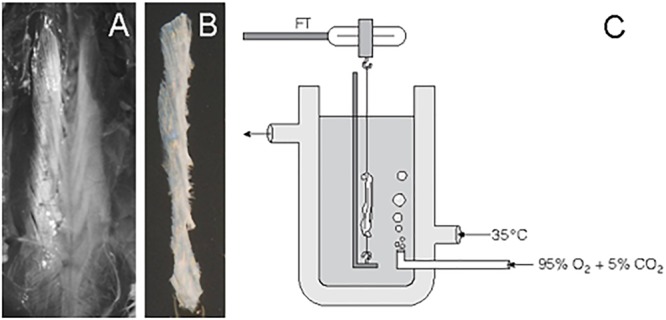
Handling of rat thoracolumbar fascia. After removal of skin and subcutaneous connective tissue, the underlying dense layer of thoracolumbar fascia was made accessible (A). One long strip from the left side of the thoracolumbar spine (shown here in B) and also one from the other side were carefully dissected and cleaned of any attached muscle fibers. Some samples were then used for histochemical analysis while others were used for mechanographic registrations in an organ bath, as shown in (C). Here the bath solution was aerated with carbogen. Through a double-walled container, the bath was kept at a constant temperature. The upper end of the tissue was connected with a force transducer (FT).